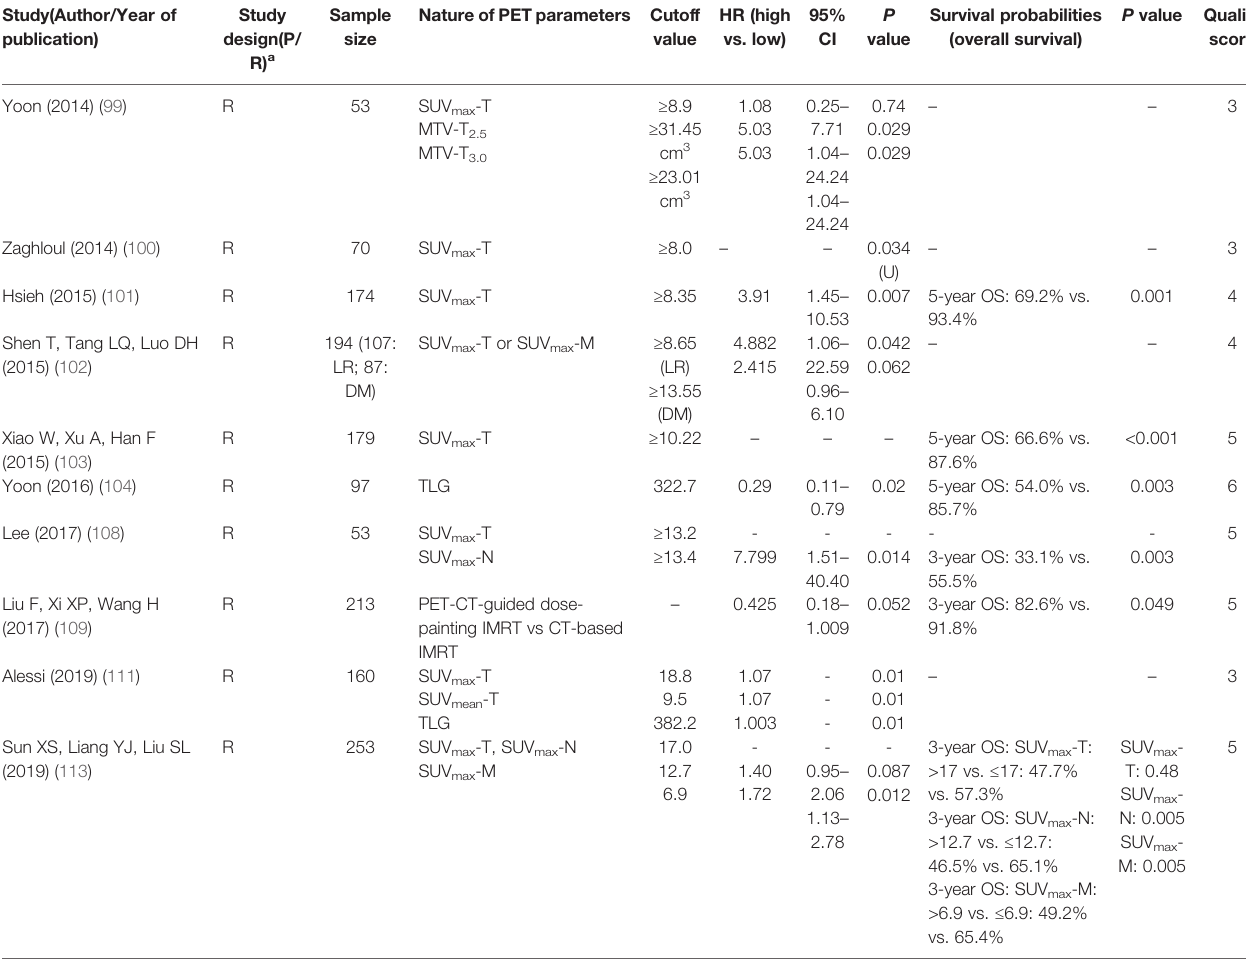
TABLE 6 | Association of overall survival with PET parameters